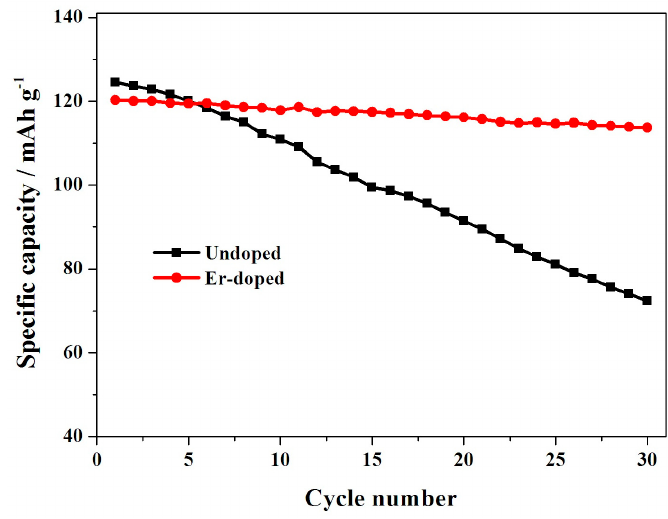
Figure 7. Cycling performance of the LiNi 0.5 Mn 1.5 O 4 and Er-doped LiNi 0.5 Mn 1.5 O 4 at 55 ◦ C.